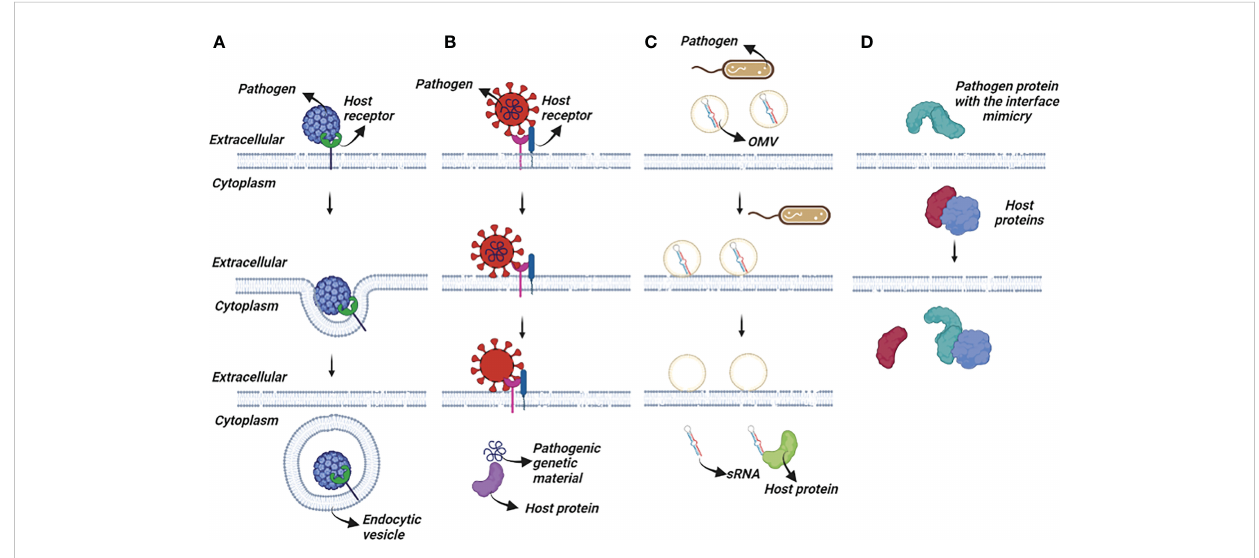
FIGURE 1 Several pathogen interaction mechanisms with the host cells. (A) Endocytic vesicle engulf the pathogen completely or partially after an initial interaction between host-pathogen proteins for recognition. (B) Pathogen proteins interact with host receptors and trigger series of cellular events. (C) Pathogenic OMVs release their content into the host cells. (D) Pathogen proteins mimic the interface of the host proteins and compete with them to bind to their